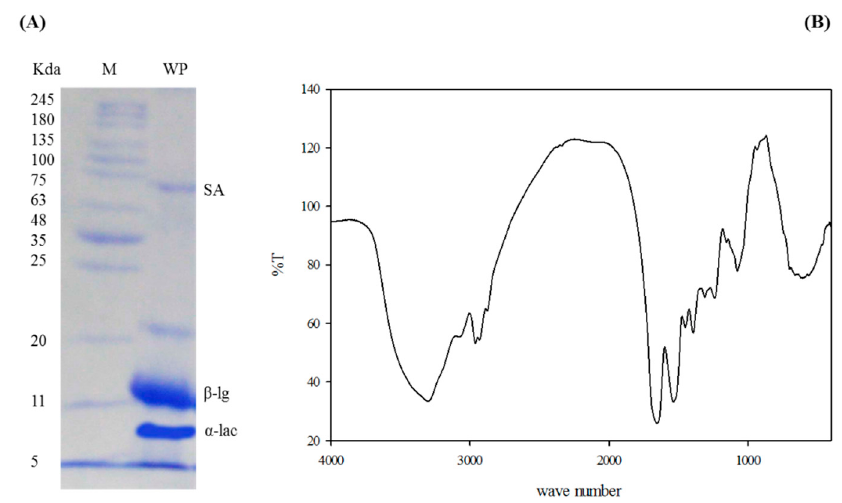
Figure 1. SDS-PAGE of whey protein concentrate ( A ). M: Protein marker; WP: Whey protein; α -lac: Alpha lacto-albumin; β -lg: Beta lacto-globulin; and FTIR spectra of whey protein concentrate ( B ).